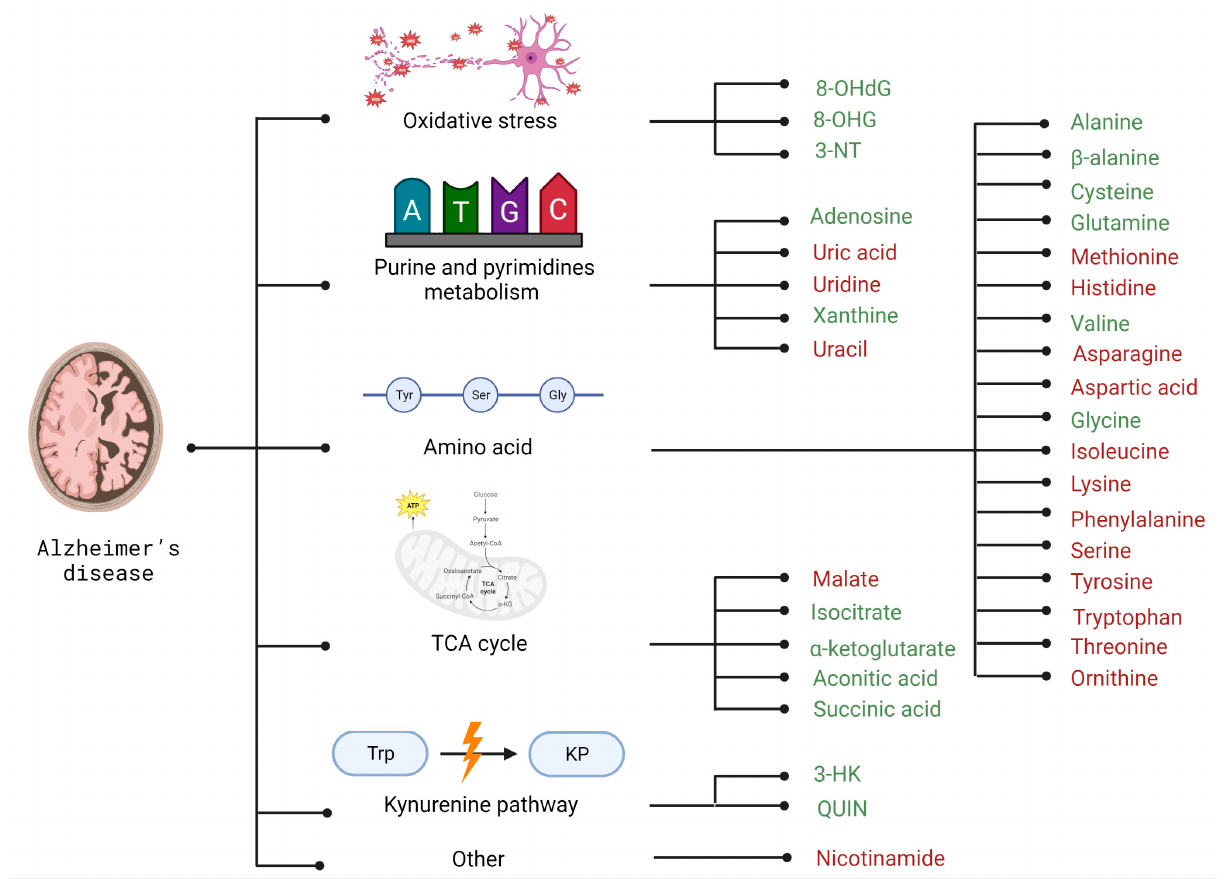
Figure 2. Biomarkers of PD related to energy metabolism disruption (green—increased levels, red—decreased levels).